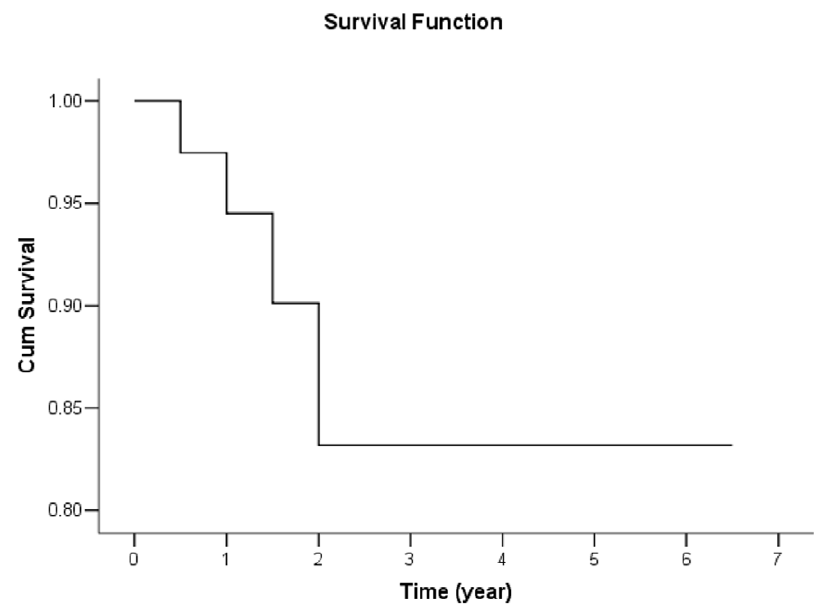
Figure 6. Kaplan-Meier plot for stroke-free survival after treatment.